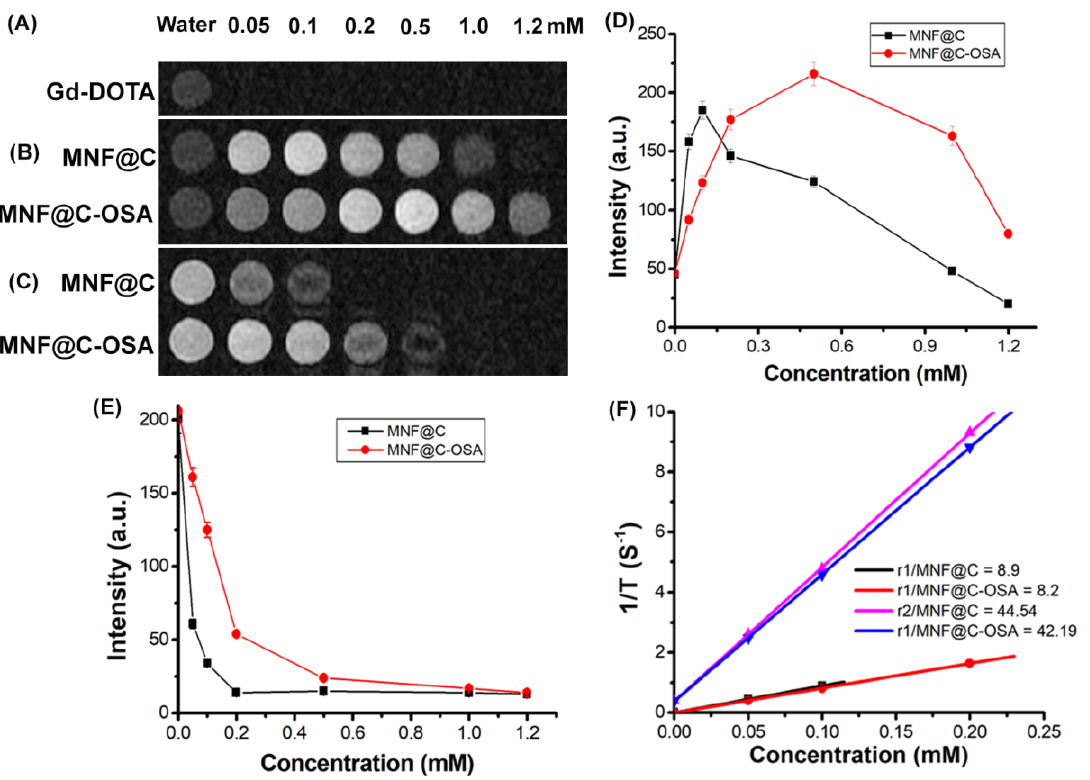
Figure 4. ( A ) T1-weighted phantom images of Gd-DOTA. ( B ) T1-weighted phantom images of MNF@C and MNF@C-OSA dots with varying concentrations; water was taken as a control. ( C ) T2-weighted phantom images of MNF@C and MNF@C-OSA dots with varying concentrations; water was taken as a control. ( D ) T1 image intensities for MNF-C and MNF@C-OSA dots were plotted against concentrations. ( E ) T2 image intensities for MNF-C and MNF@C-OSA dots were plotted against concentrations. ( F ) Relaxivities were plotted against concentrations to determine molar relaxivities.